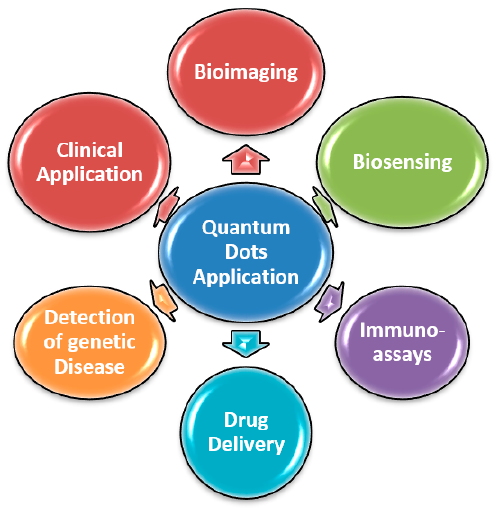
ff erent application of quantum Figure 1. Different application of quantum dots. Figure 1. Di